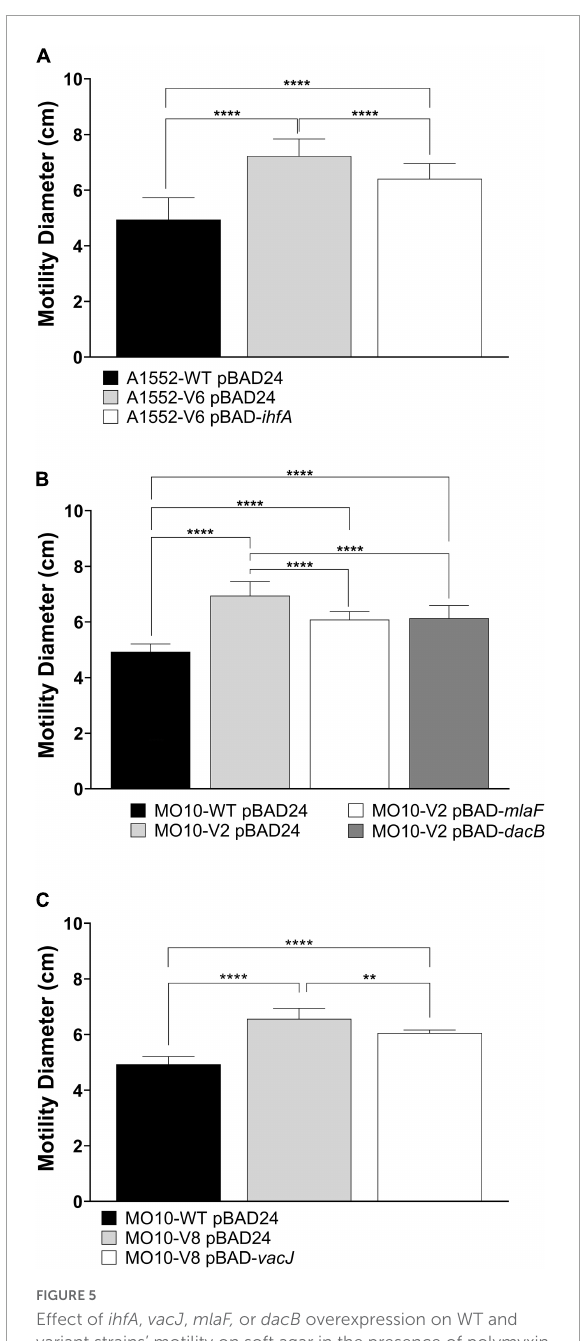
FIGURE5 Effect of ihfA , vacJ , mlaF, or dacB overexpression on WT and variant strains’ motility on soft agar in the presence of polymyxin B. (A) A1552-WT and A1552-V6 carrying pBAD24 or pBAD24- ihfA , (B) MO10-WT and MO10-V2 carrying pBAD24, pBAD24- mlaF or pBAD24- dacB , and (C) MO10-WT and MO10-V8 carrying pBAD24 or pBAD24- vacJ. Data